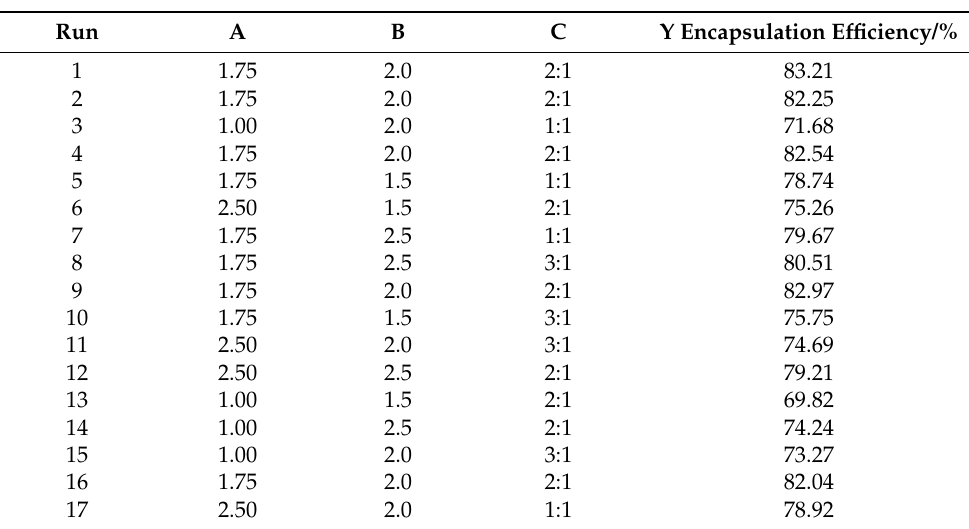
Table 2. The experimental run from Box–Behnken Design